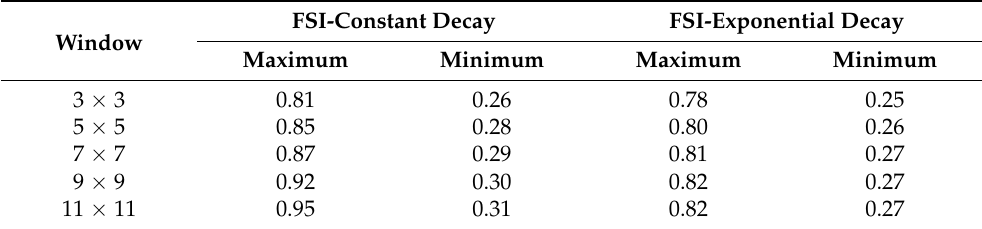
Table 6. Statistical validation by Hagen’s method: 2018–2021.